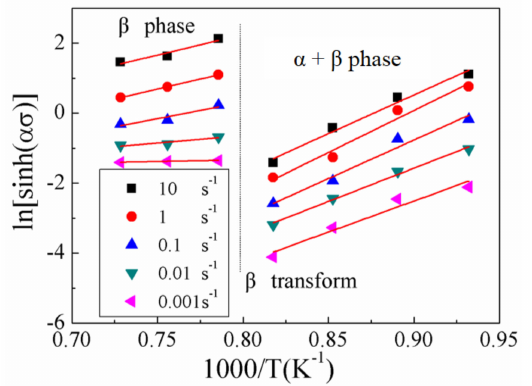
Figure 12. Relationships between 1000/ T and ln [ sinh ( ασ )] .